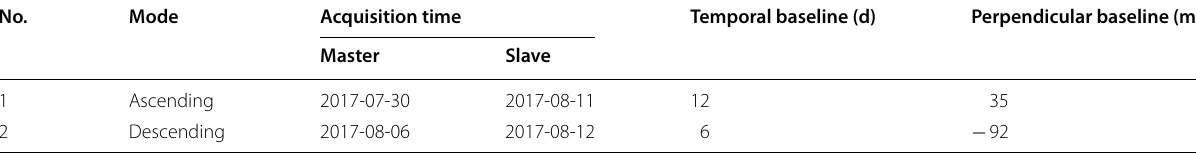
Table 2 InSAR information for Sentinel-1A images